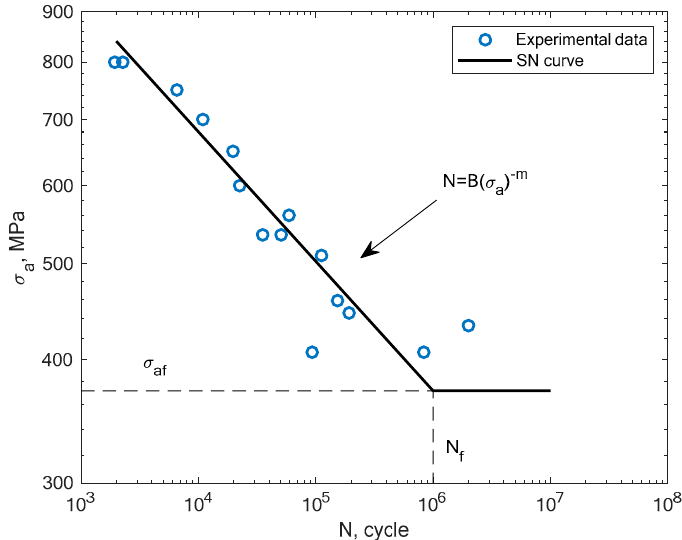
Figure 7. S–N curve for the experimental tension–compression fatigue test results of 1.2709 steel obtained by the authors under R = − 1.